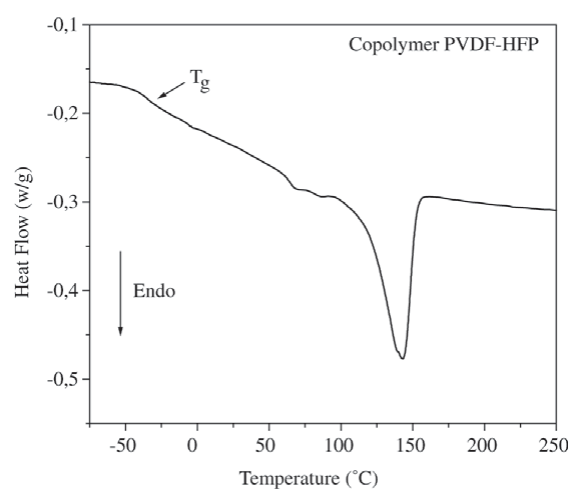
Figure 8. DSC thermogram of the PVDF-HFP copolymer